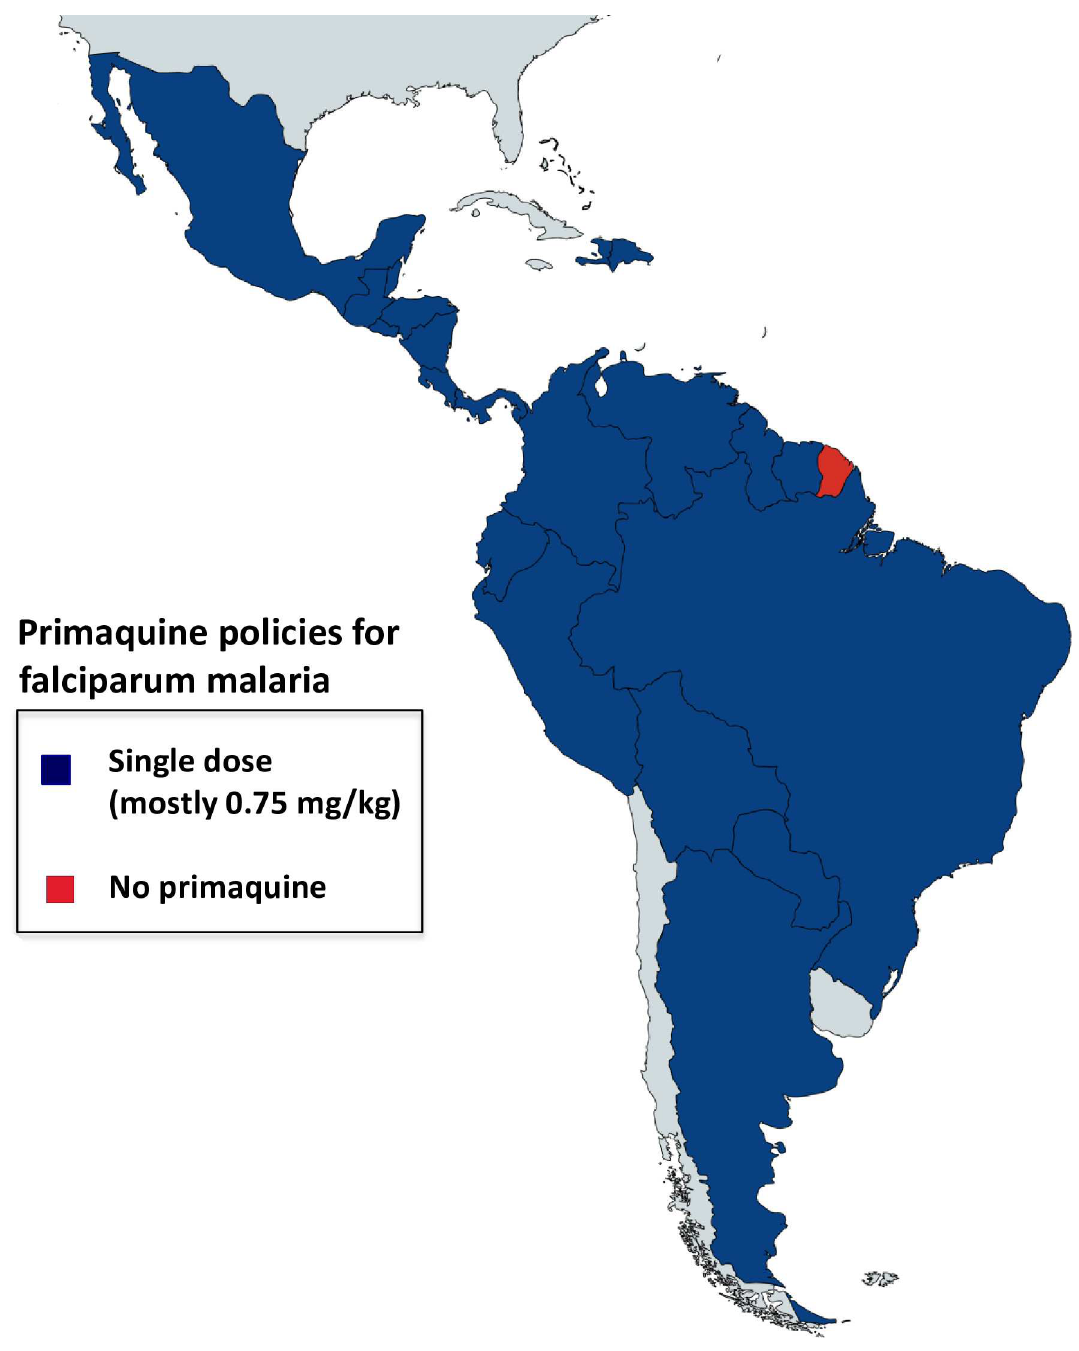
Fig 5. Single dose primaquine policies in American countries. All countries use single dose primaquine (mostly 0.75 mg/kg) as policy for falciparum treatment (shown in blue) except for French Guiana (red), with no G6PD deficiency testing required before primaquine administration. Table 6 provides details on countries’ policies and implementation and/or upcoming